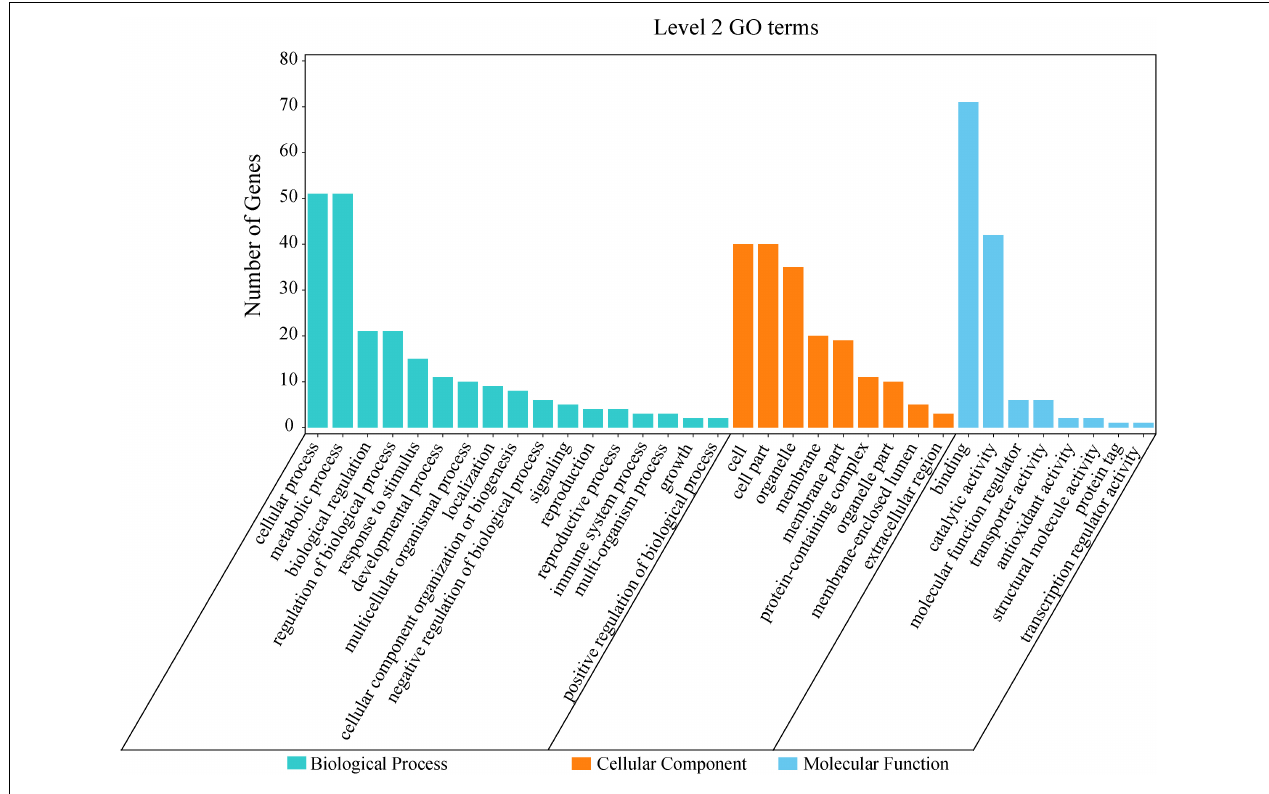
FIGURE 6 | Level 2 GO terms for 134 putative candidate genes from MQTL